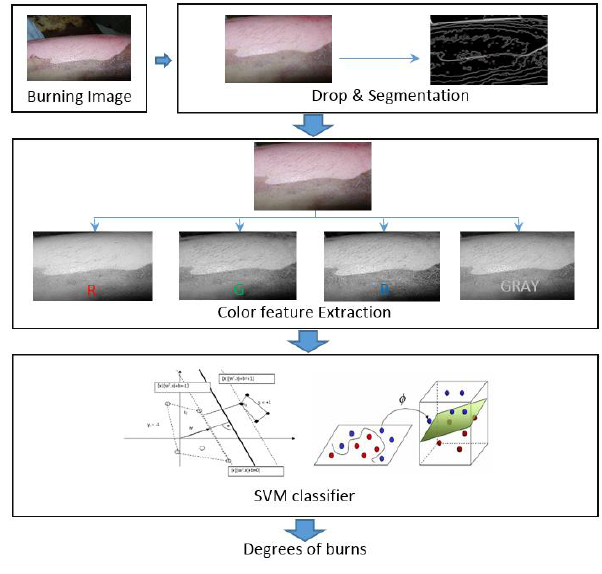
Fig. 13. Burning image classification model